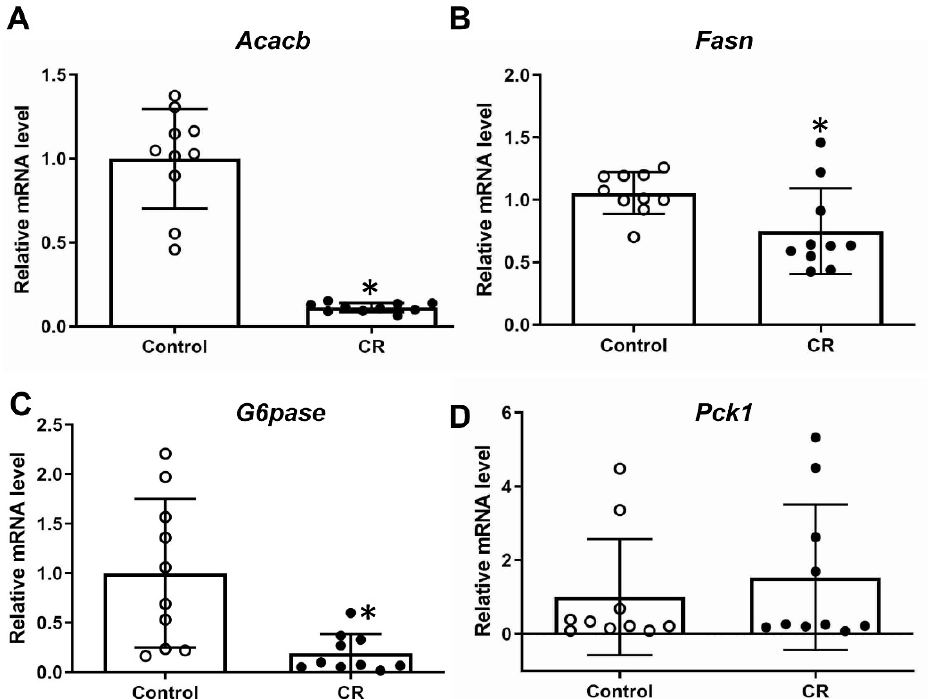
Figure 3. Relative mRNA expression of key lipogenic (Acacb: ( A ); Fasn: ( B )) and gluconeogenic (G6pase: ( C ); Pck1: ( D )) gene expression in WT embryos. n = 10 per group, * p < 0.05. Control: fed ad libitum; CR: calorie restriction.